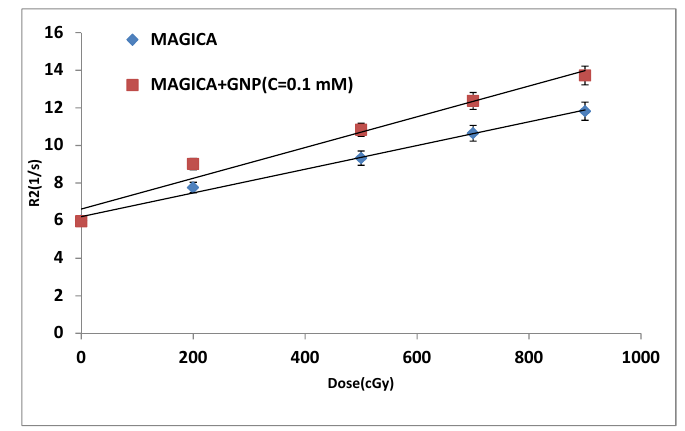
Fig. 7. Dose enhancement factor performed with MAGICA gel with 0.1 mM GNPs